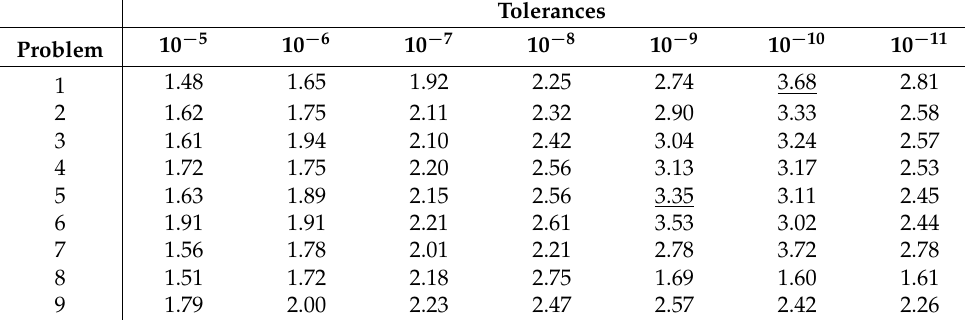
Table 2. Efficiency measures ratios of DLMP6(5) vs.